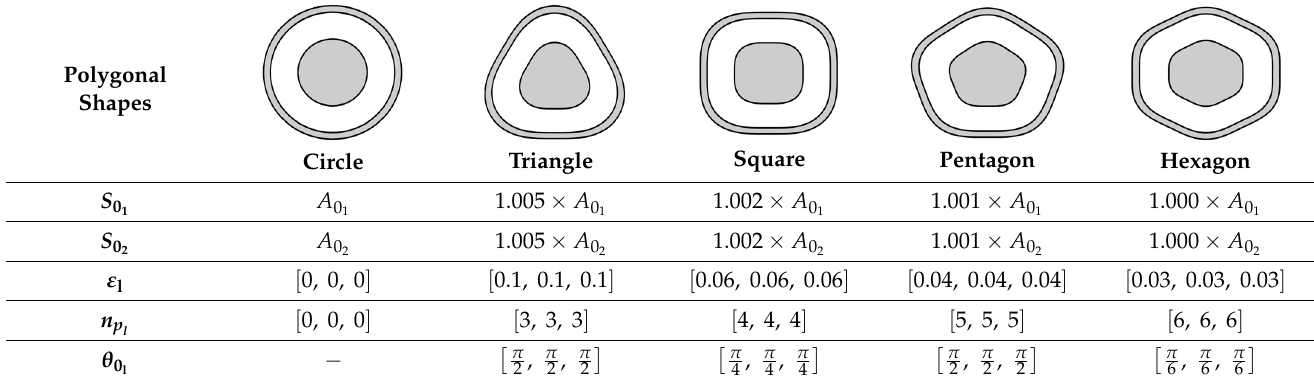
Table 1. Regular polygonal platform and ring shapes created from the cosine-type radial perturbation